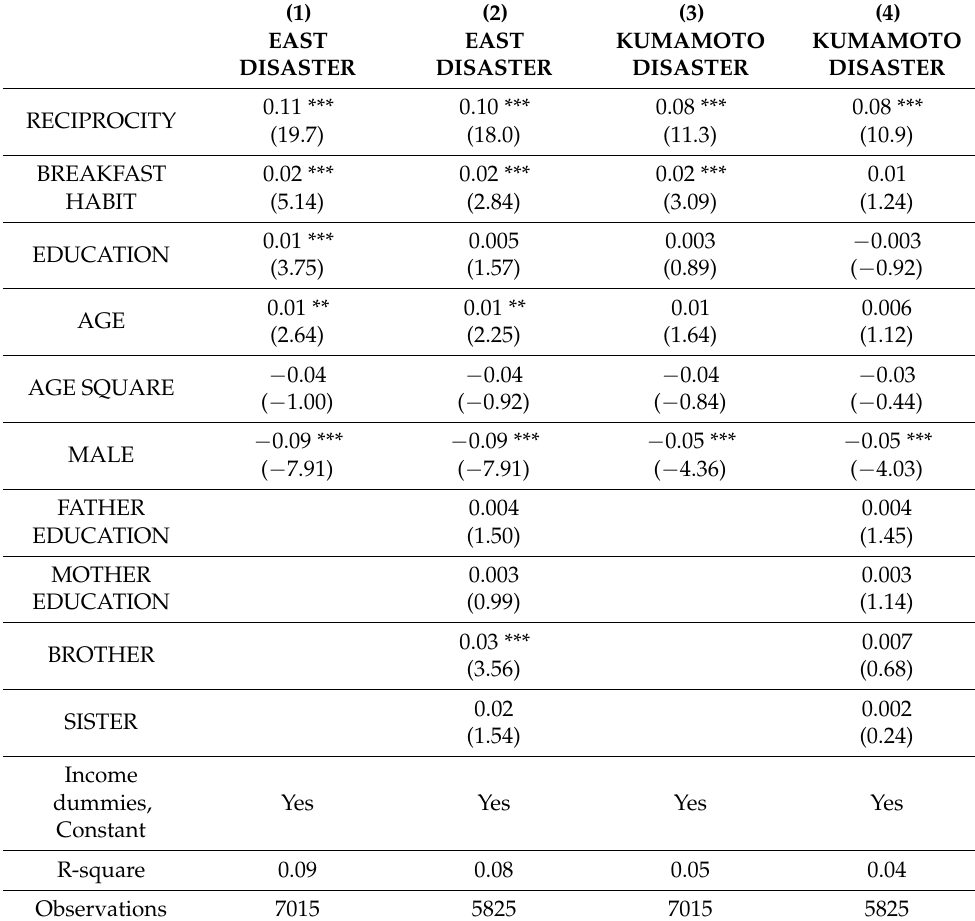
Table 2. Baseline estimation about determinants of charitable donation (OLS model): Dependent variable is EAST DISASTER and KUMAMOTO